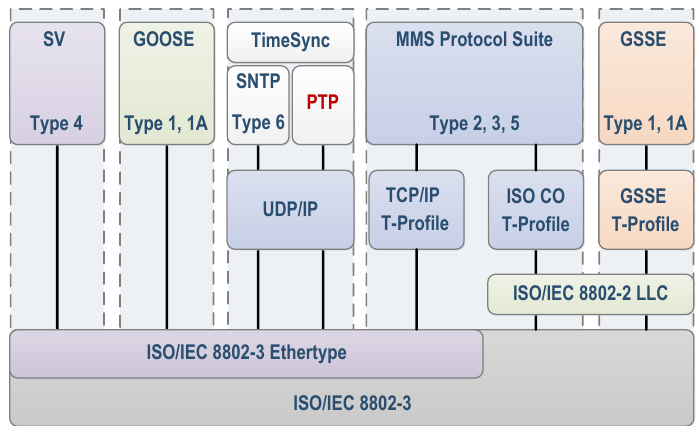
Figure 14. International Electrotechnical Commission (IEC) 61850 communication profiles [57]. GOOSE: Generic object-oriented substation event; MMS: Manufacturing Message Specification; SNTP: Simple Network Time Protocol SV: Sampled